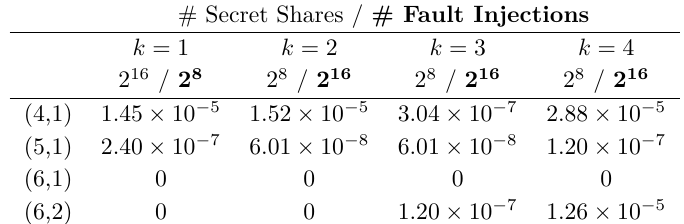
Table 11: Probabilities of generating undetectable faults for Exp 254 and τ A ◦ Exp 254 using SAGE